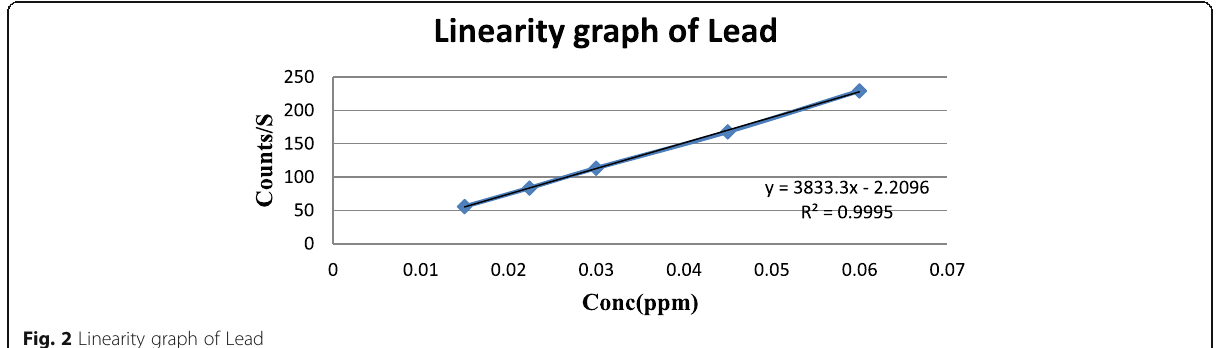
Fig. 2 Linearity graph of Lead